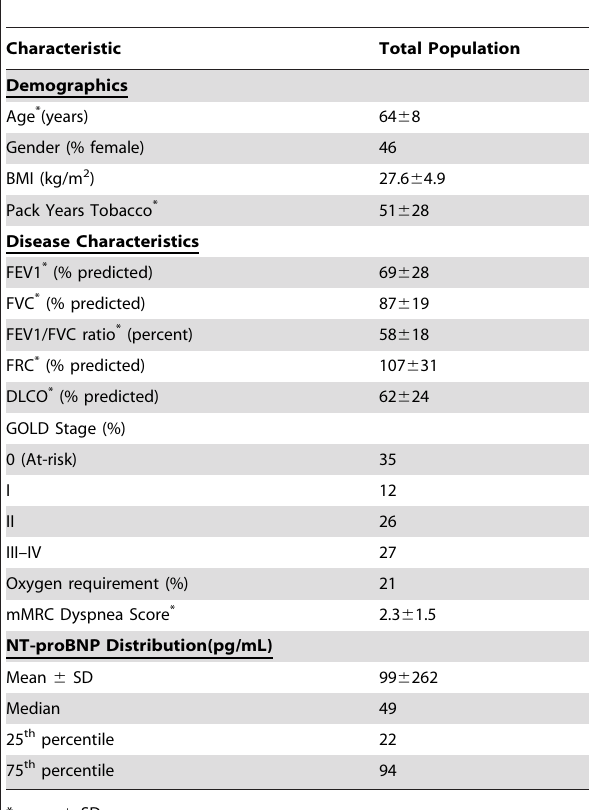
Table 1. Baseline Characteristics of the Total Study Population.